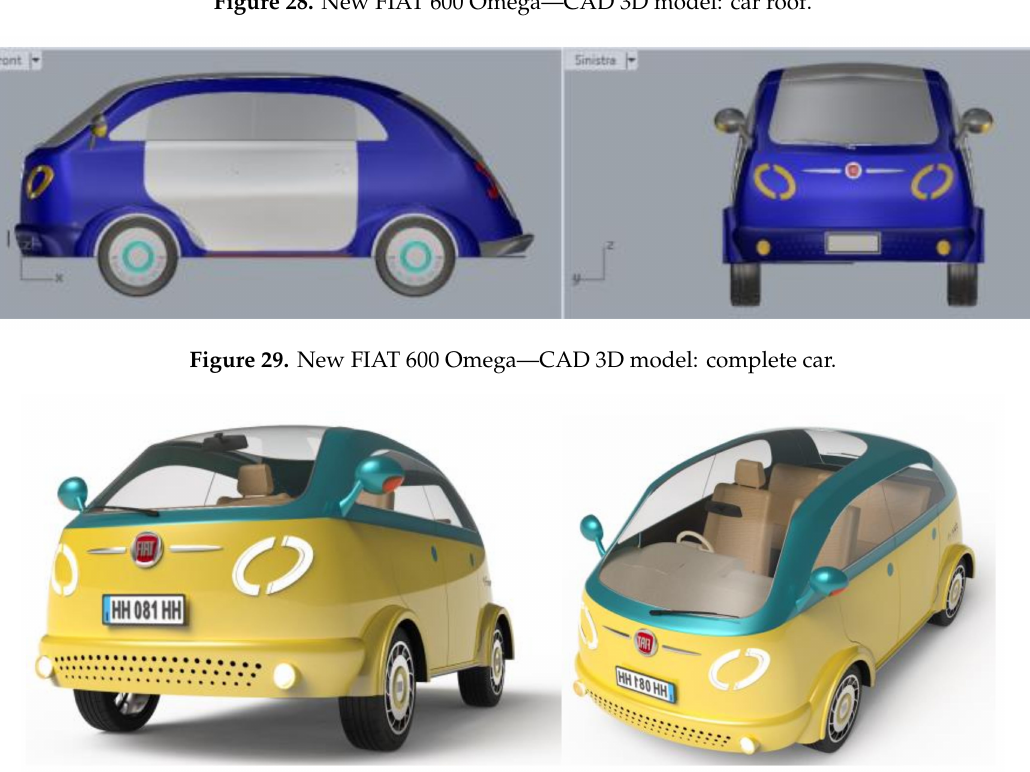
Figure 30. New FIAT 600 Omega – CAD 3D model and details: front